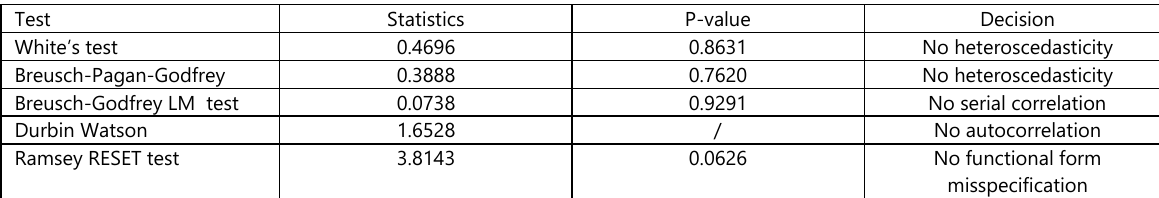
Table 5: ARDL Diagnostic Tests (Source: Author’s calculations) Test White’s